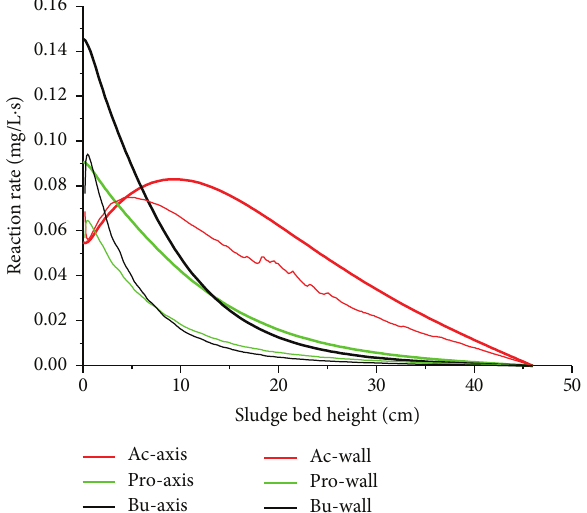
Figure 6: VFA degradation rates along sludge bed height at reactor axis (axis) and near reactor wall (wall) (mg/L ⋅ s).